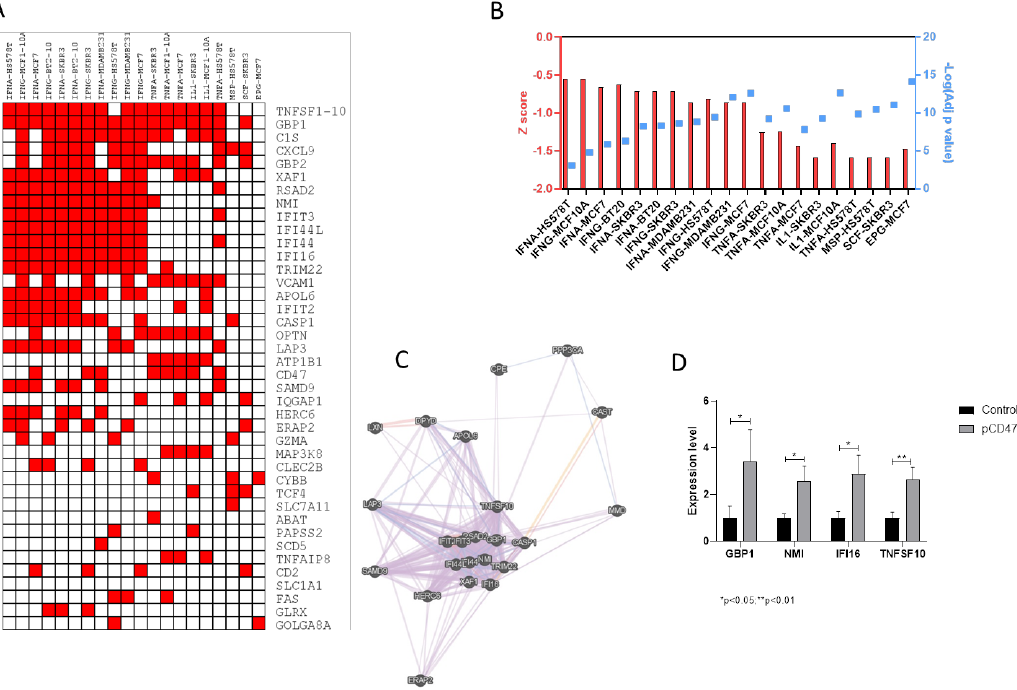
Figure 3. ( A ) Clustergram of Single Ligand Perturbation analysis for the upregulated genes in patients with high CD47 expression levels as compared to patients with low CD47 expression levels; ( B ) Histogram plot for Single Ligand Perturbation analysis for the downregulated genes in patients with high CD47 expression levels as compared to patients with low CD47 expression levels showing Z score and significance of the top 20 categories; ( C ) Gene network analysis of IFN-alpha-related genes di ff erentially expressed in patients with high CD47 expression levels vs. patients with low CD47 expression levels; ( D ) PCR analysis of selected genes in 92.1 cells overexpression